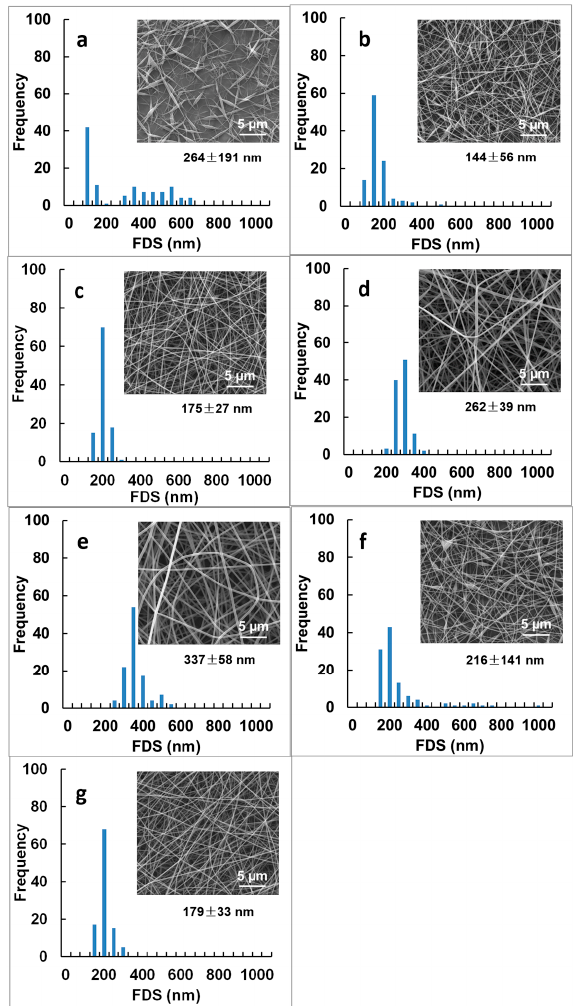
Figure 4. SEM images and fiber diameter size (FDS) of electrospun PVA nanofibers reinforced with TA-Fe +++ (II) complexes as function of PVA concentration: ( a ) 4 wt %; ( b ) 6 wt %; ( c ) 8 wt %; ( d ) 10 wt %; and ( e ) 12 wt %; and of ( f ) 8 wt % PVA and ( g ) 8 wt % PVA/TA. Experimental details of the spinning solutions can be found in Table 1. Magnification is 10,000×.